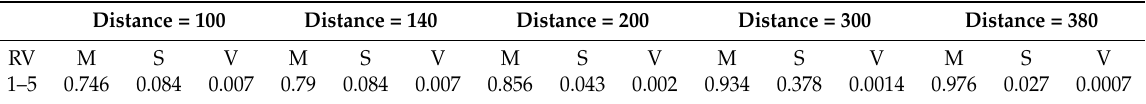
Figure 6. The line of view of the driver with the left mirror improperly adjusted. Table 3. Statistical dispersion of the data with respect to Mean (M), Standard Deviation (S) and Variance (V).